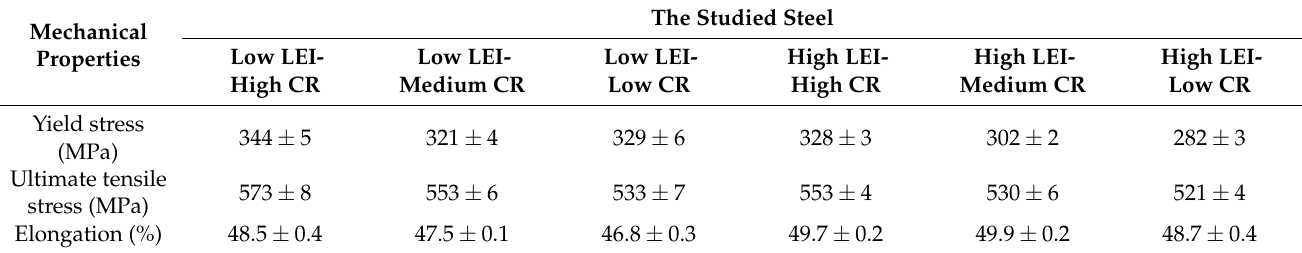
Figure 8. Histogram of mechanical properties of longitudinal tensile samples under different LEIs. Table 4. Summary of the mechanical properties of the studied steel under different LEIs and CRs.